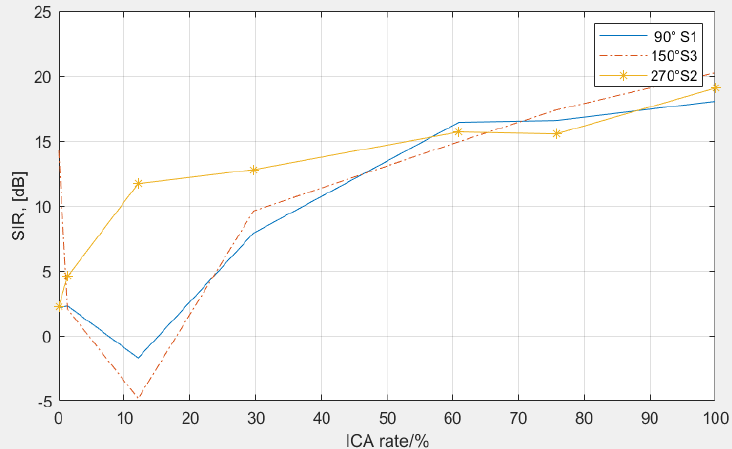
Figure 8. SIR improvement with separation under three sources in Room A.